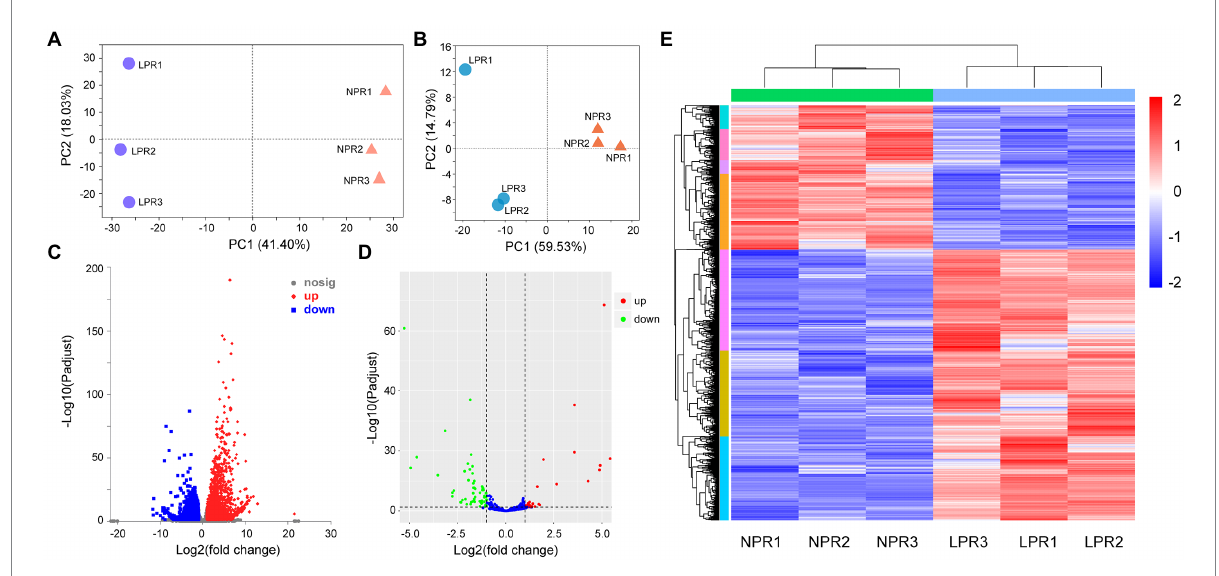
FIGURE 1 The profiles of differentially expressed genes (DEGs) and differentially expressed miRNAs (DEMs)under Pi deficiency conditions. (A) The principal component analysis (PCA) of DEGs under normal and Pi deficient conditions. (B) The PCA of DEMs under normal and Pi deficient conditions. (C) The volcano of DEGs. (D) The volcano of DEMs. (E) The profiles of DEGs in different libraries. NPR represents alfalfa seedlings roots under normal phosphate treatment. LPR represents alfalfa seedlings roots under phosphate deficiency treatment. Red or blue box indicates increase or decrease in the fold change value. Full red indicates ≥ 2-fold change. Full blue indicates ≤ − 2-fold